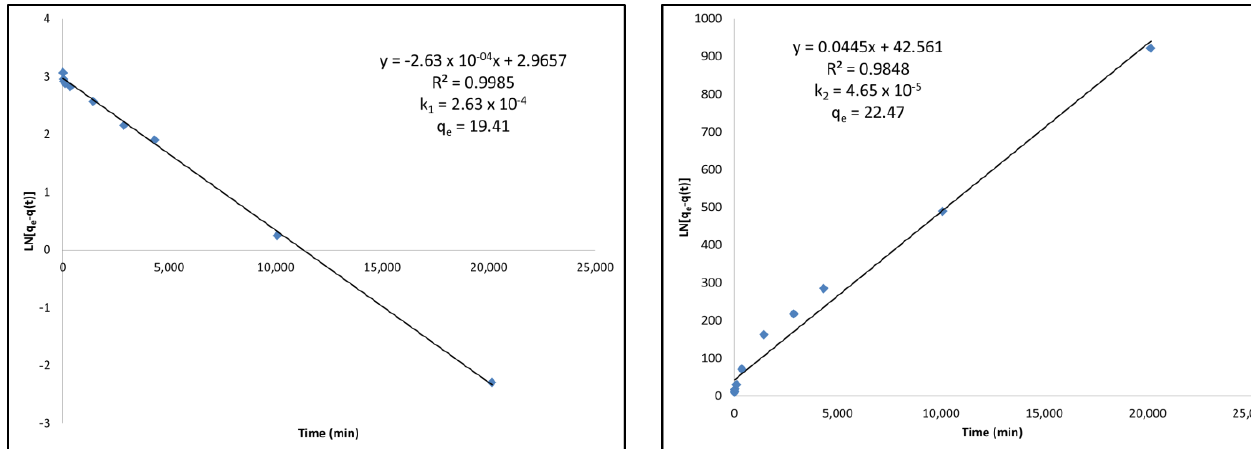
Figure A2. ( Left ) Pseudo-first-order kinetic modeling of NH 4+ -Adsorbed activated carbon under Langmuir adsorption kinetics equations. ( Right ) Pseudo-second-order kinetic modeling of NH 4+ -Adsorbed activated carbon under Langmuir adsorption kinetics equations.